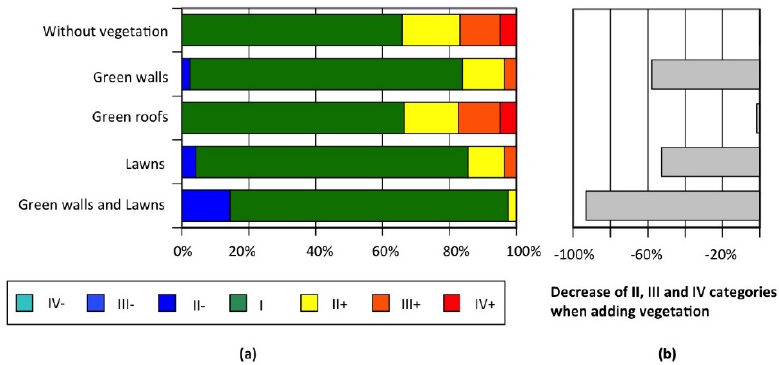
Figure 15. ( a ) Distribution of occurrences among thermal comfort categories for the third floor; and ( b ) relative decrease in the occurrences of hot categories compared to the reference